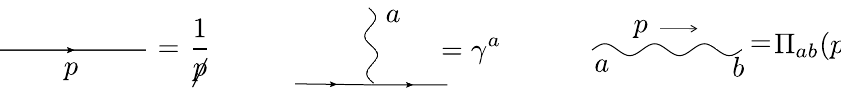
Figure 6 . Feynman rules. (cid:5)